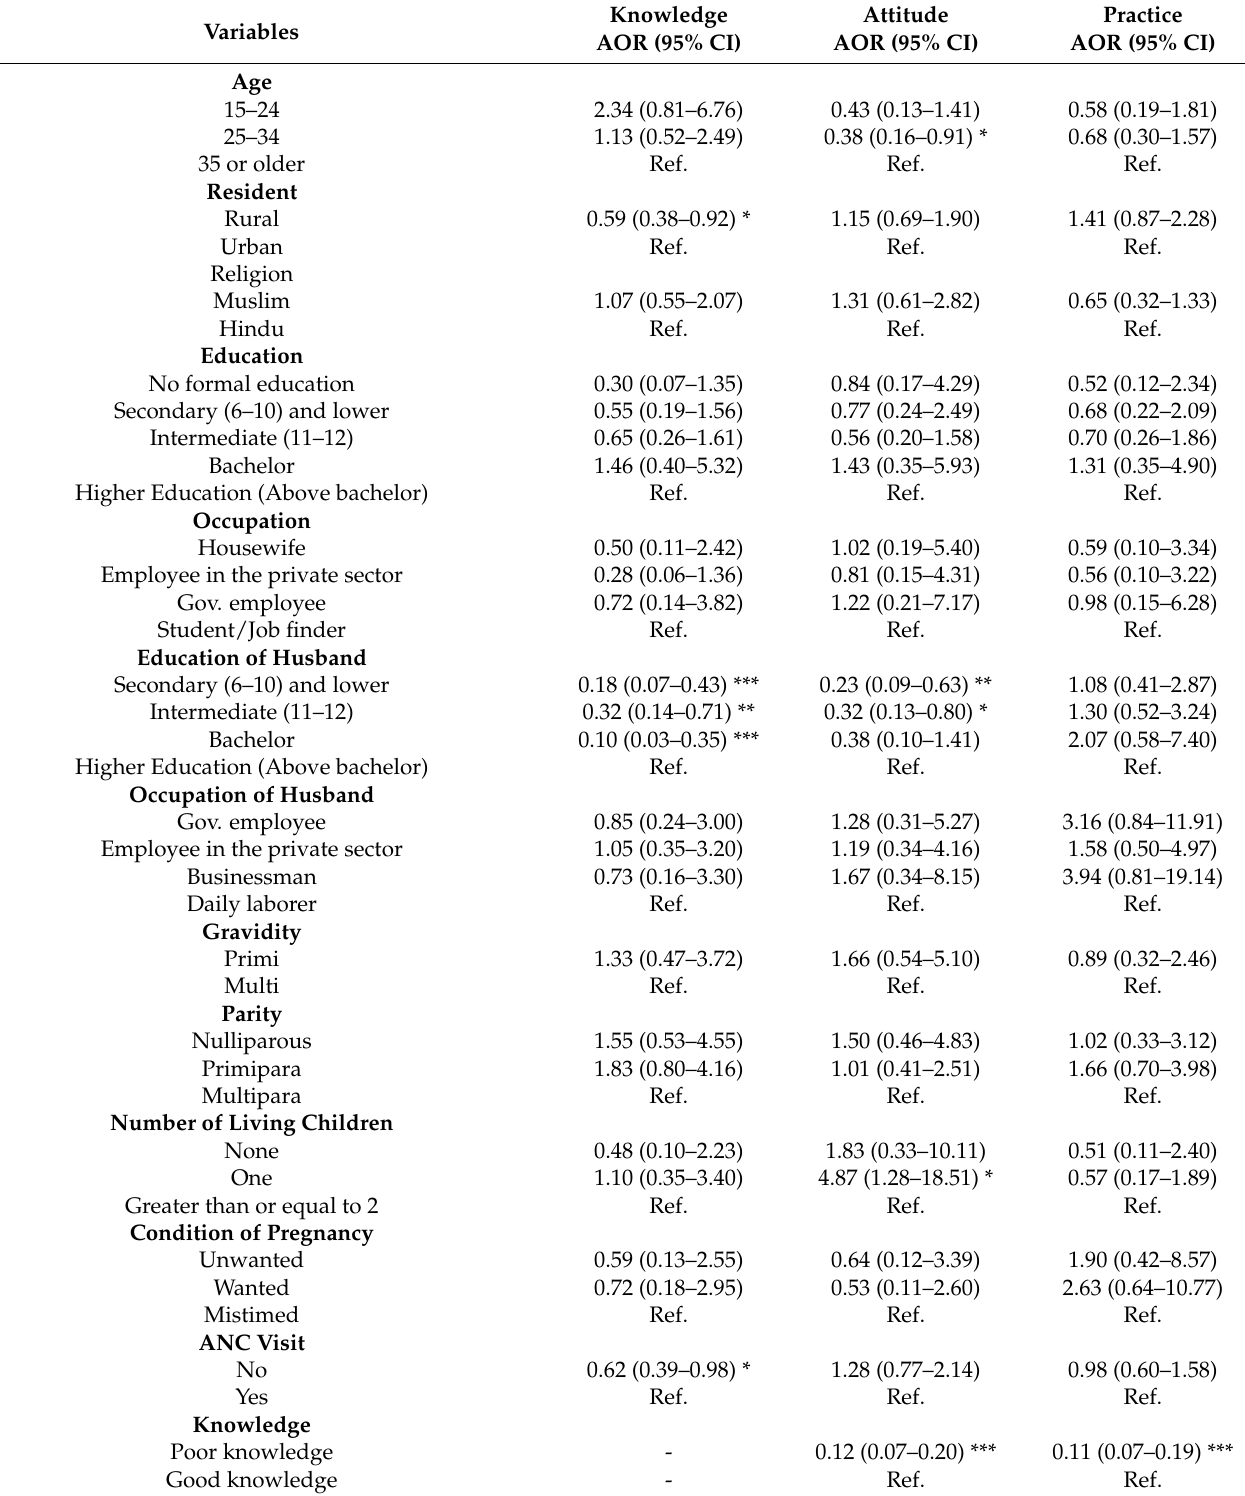
Table 4. Multivariable analysis of factors affecting KAP towards